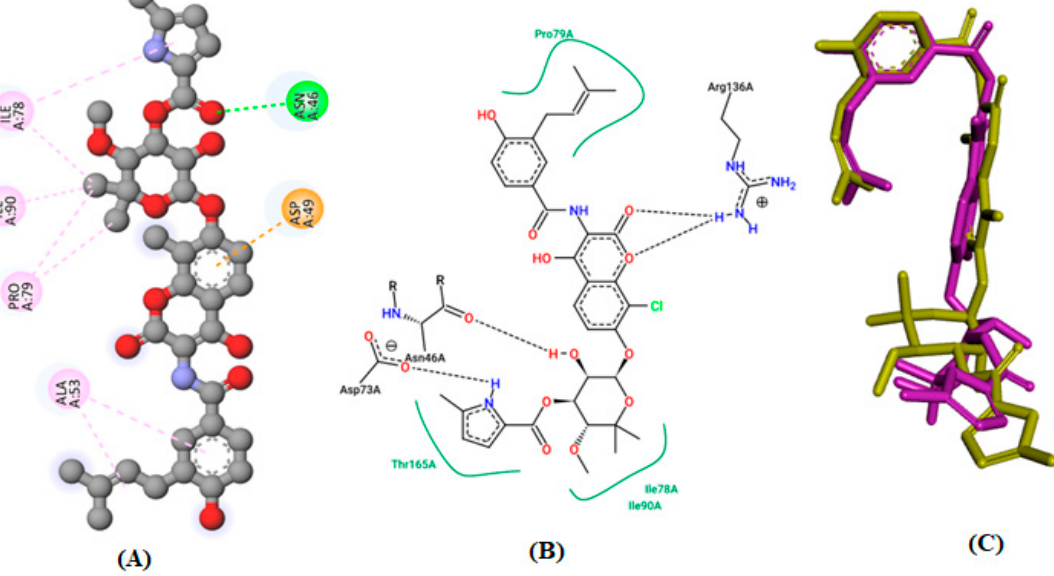
Figure 3. The results of intermolecular interaction between 1JIJ.pdb protein and co-crystallized ligand, which are produced computationally ( A ) and experimentally ( B ), and the result of superposition pose with RMSD of 1.375 Å ( C ).